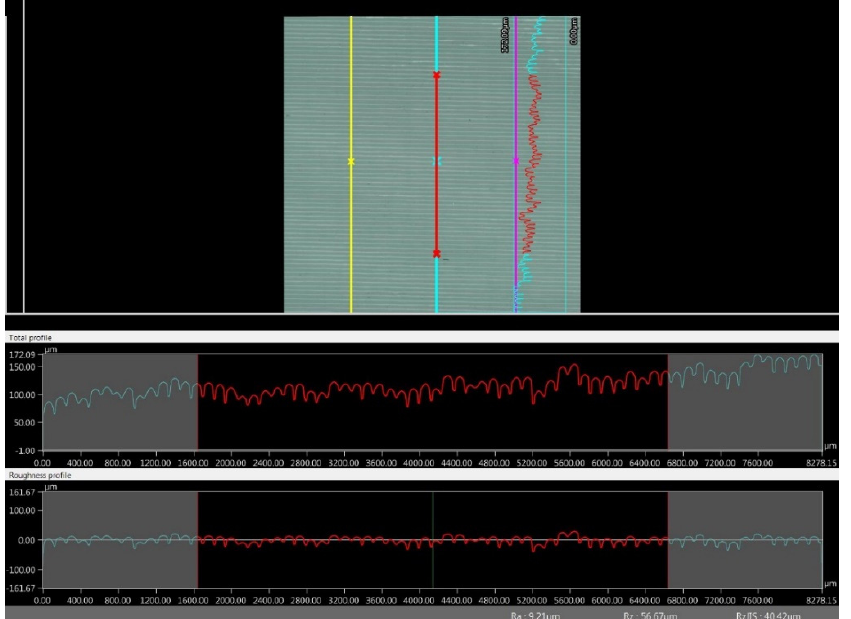
Figure 10. Profile measurement in the header of the n07 system. The maximum Rz value for this measurement was slightly higher (56.67 µm) than the average value.